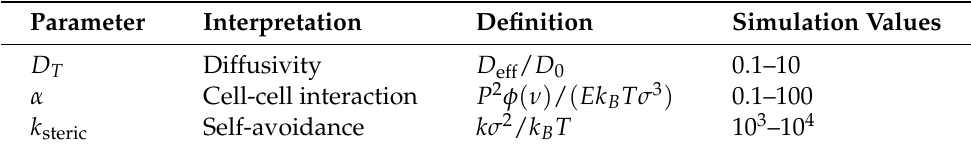
Table 2. Simulation parameters and their